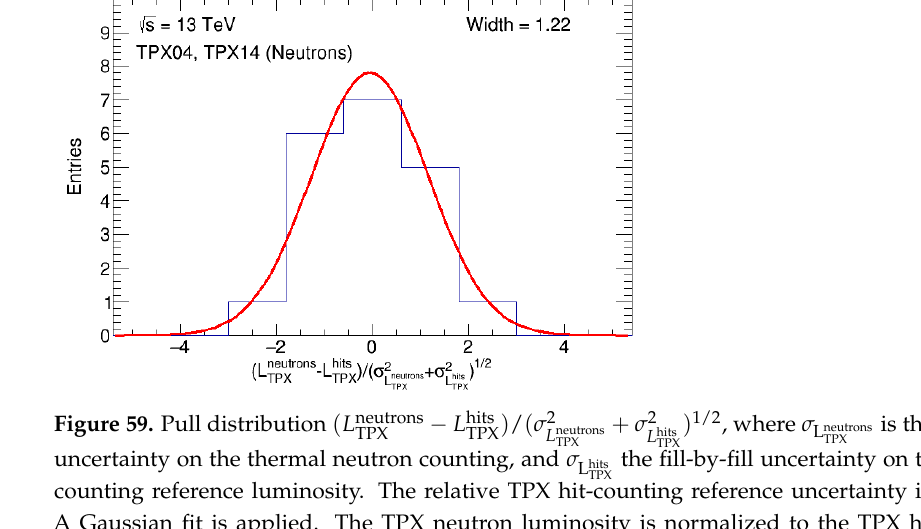
Figure 59. Pull distribution ( L neutrons uncertainty on the thermal neutron counting, and σ counting reference luminosity. The relative TPX hit-counting reference uncertainty is 0.5% [14]. A Gaussian fit is applied. The TPX neutron luminosity is normalized to the TPX hit-counting luminosity [14]. The data of the devices TPX04 and TPX14, layers 1 and 2, are combined. Taken from Ref.